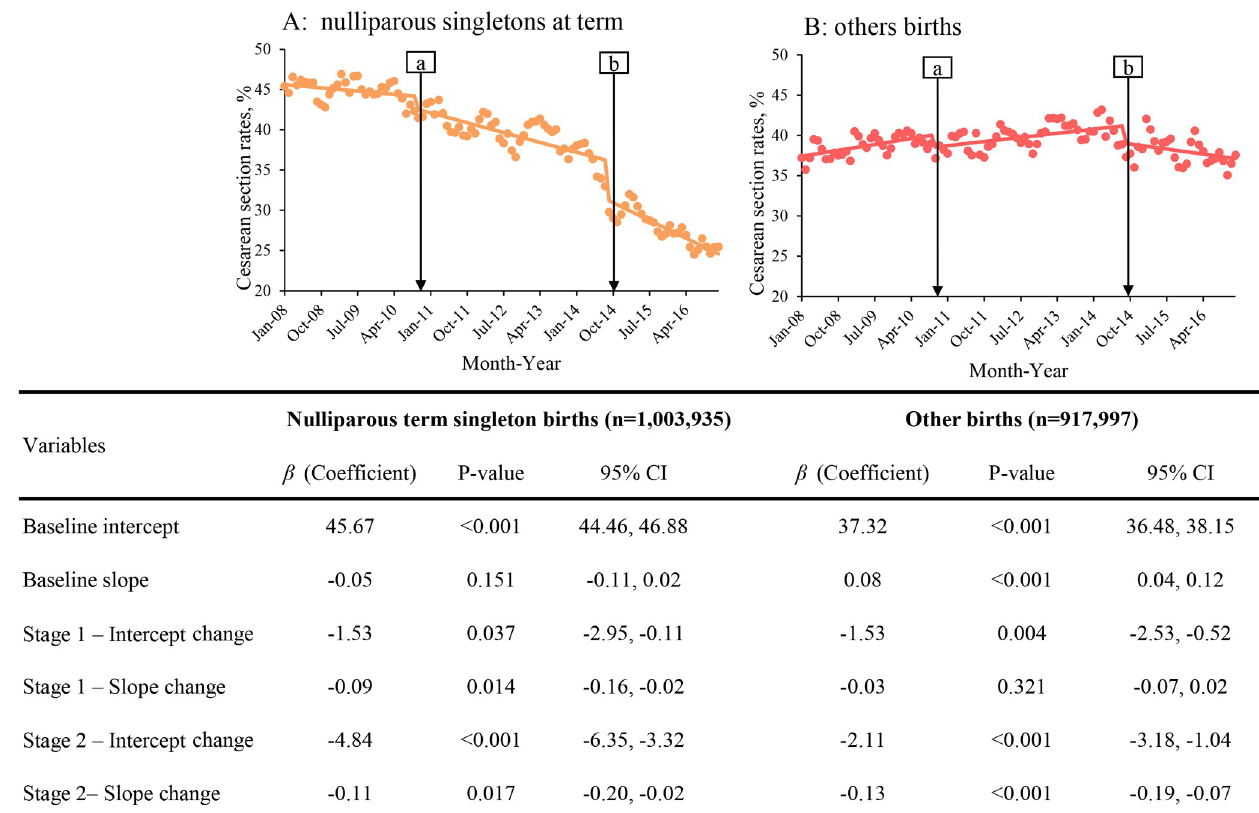
Fig 2. Segmented linear regression models of age-standardized CS rates in nulliparous singletons at term (A) and other births (B) in Guangzhou, China, 2008–2016. Dots indicate true monthly CS rates; solid lines indicate the mean of estimated CS rates per month. Baseline: from January 2008 to September 2010; Stage 1: from October 2010 (Point “a”) to September 2014; Stage 2: from October 2014 (Point “b”) to December 2016. Age-standardized CS rate was calculated by the direct method using 2008 population in each group in the study. Variables listed were modeled along with autoregressive terms by subset models that list the lags in the autoregressive model. Intercept change: change in level compared with the previous stage; slope change: change in trend compared with the previous stage, per month. CS, cesarean section.